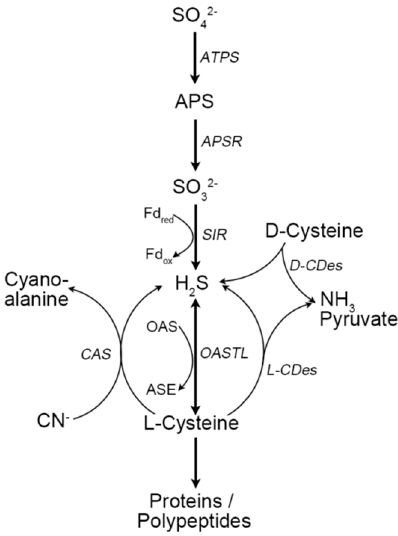
Figure 1. The synthesis and metabolism of H 2 S in higher plants. H 2 S is generated coincident with sulfate reduction in the plant cell. The key enzymes in H 2 S biosynthesis and metabolism include sulfite reductase (SIR), L-cysteine desulfhydrase (L-CDes), D-cysteine desulfhydrase (D-CDes), β -cyanoalanine synthase (CAS), and O-acetylserine(thiol)lyase (OAS-TL). Plants are capable of reducing activated sulfate (SO 42 − ) to sulfite (SO 32 − ), after that SIR catalyzes SO 32 − to H 2 S, with ferredoxin (Fd red ) as the electron donor. In the presence of OAS-TL, the generated H 2 S is reversibly reduced to L-cysteine by reacting with O-acetylserine (OAS). L-CDes and D-CDes catalyze the degradation of L / D-cysteine to produce H 2 S, amine (NH 3 ) and pyruvate to maintain H 2 S homeostasis. CAS, located in the mitochondria, can also catalyze the production of H 2 S, using cyanide (CN − ) and cysteine as substrates, removing the toxin cyanogen.